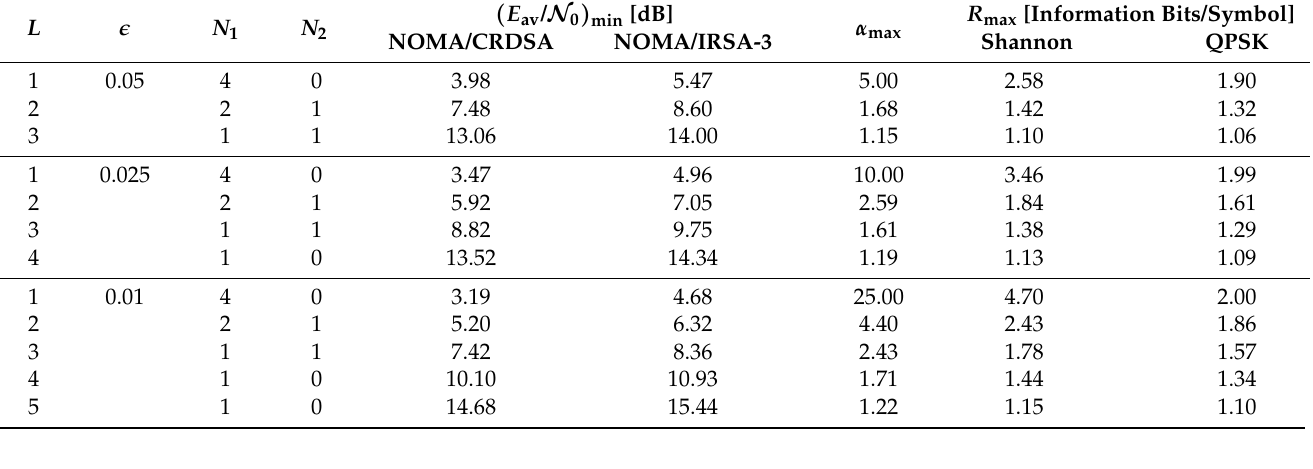
Table 3. Relationship between energy requirement and sustainable rate for different scenarios.